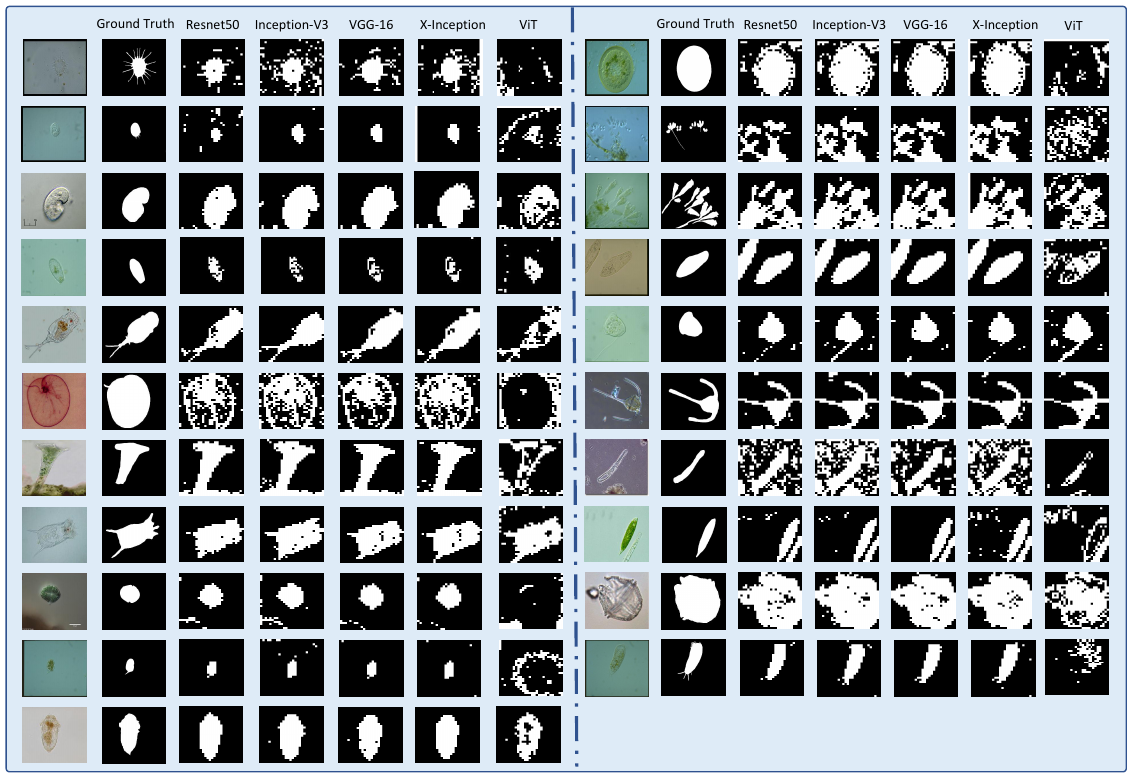
Figure 7. Reconstruct the 8 × 8 pixel patch transparent image segmentation results. (The figure contains the original image, ground truth image and Resnet50, Inception-V3, VGG-16, Xception, ViT network model predicted segmentation